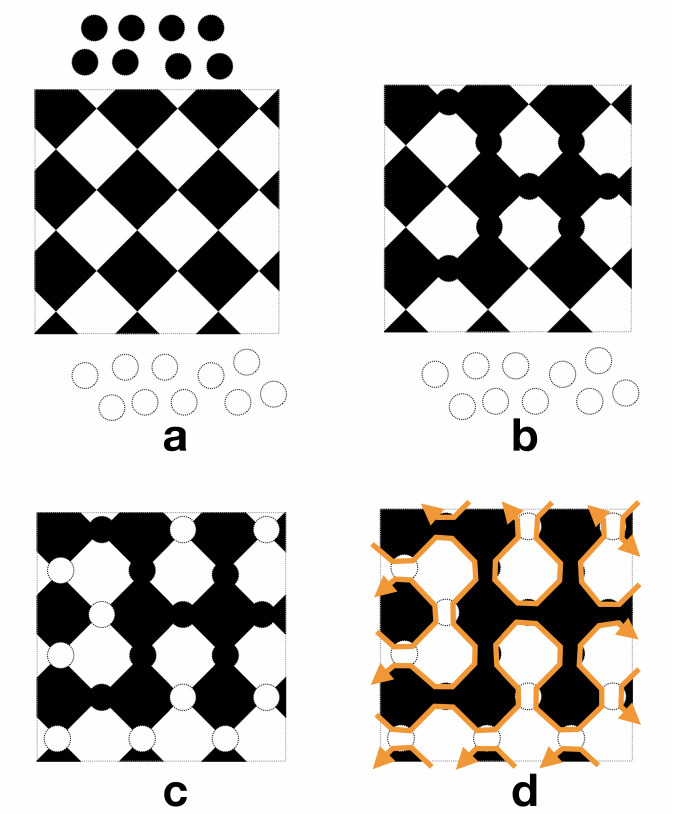
Figure 14. The game of finding an A-trail on a basket map: ( a ) A torus basket map with g = 1, B = 9, and W = 9; ( b ) state of play after black has connected all B black regions with his B − 1 chips; ( c ) final state of play after white has claimed the remaining intersections using all of her W − 1 + 2 g chips; and ( d ) the oriented A-trail that follows the black/white boundary, with black on the